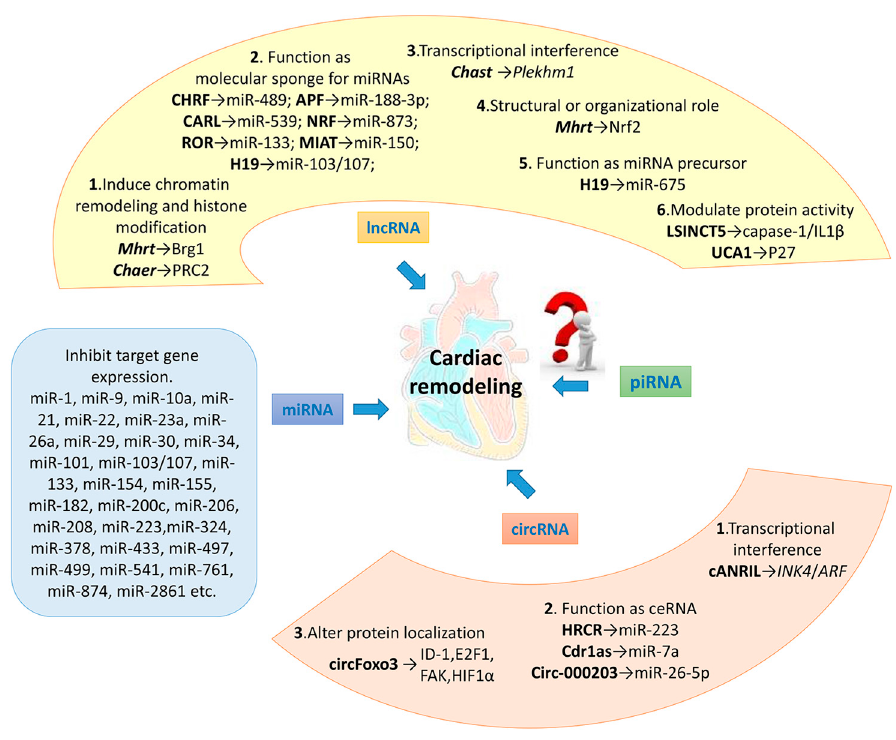
Figure 2. Summary of the ncRNAs and their molecular mechanisms in cardiac remodeling.